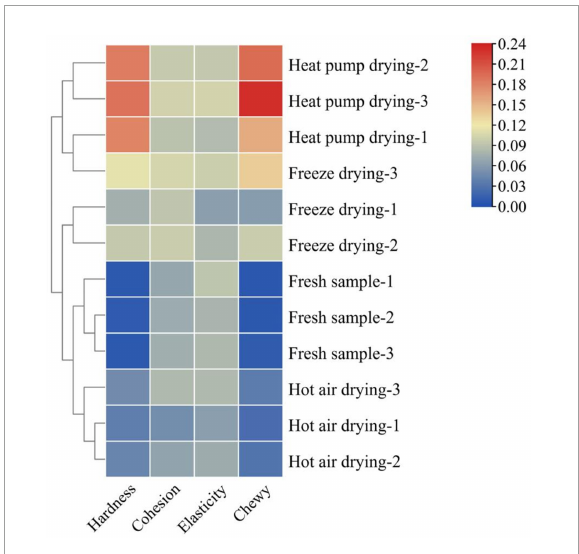
FIGURE1 Effects of different drying methods on the texture of fish filets. Color indicates the value: red indicates the higher value, blue indicates the lower